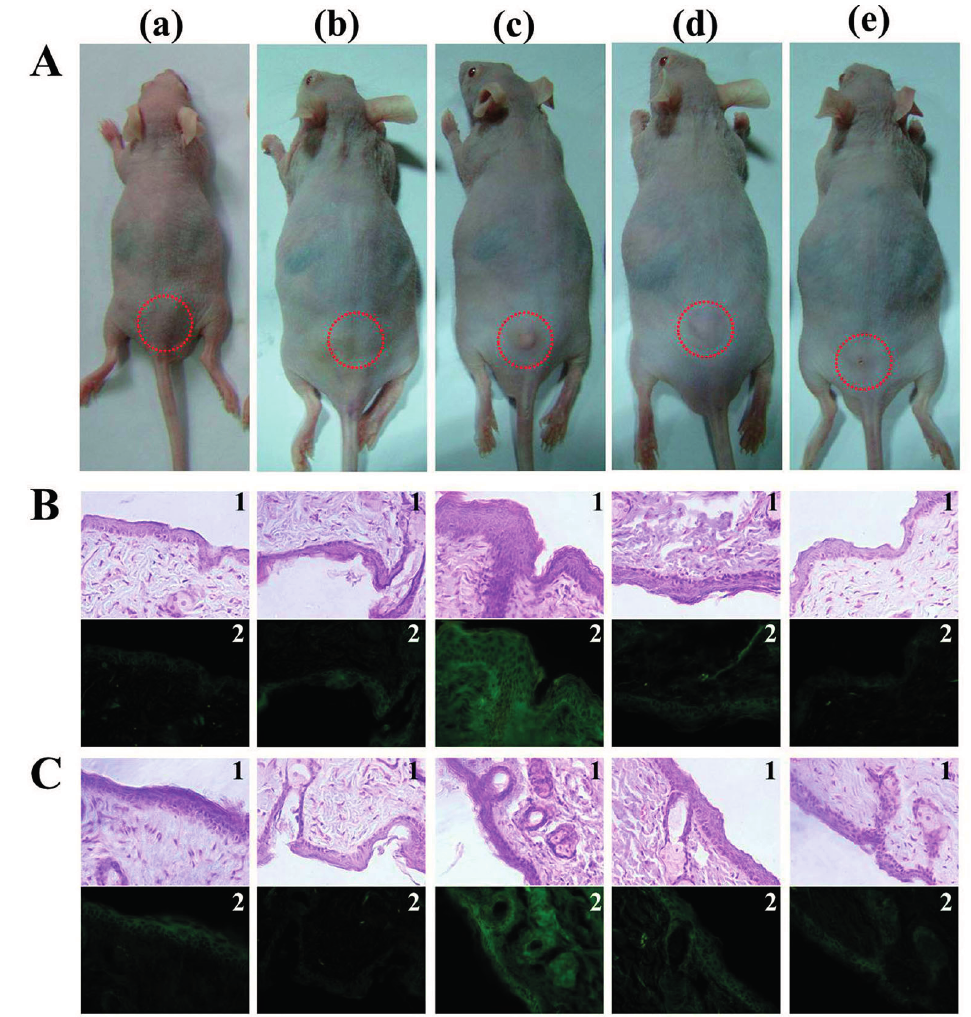
Figure 6. Topical application of beta-chitosan on the back skin of hairless mouse causes histological changes of dermatitis. S. aureus BMP-Sa003 (5 × 10 8 CFU/mL) was injected into back skin of hairless mouse, following injection of 0.5 or 1 mg/mL of β 10k chitosan. After immolation of mice ( A ) at 7 days, the tissues of dorsal skin was stained with hematoxylin and eosin staining (H & E) ( 1 ), and detected TNF- α ( B ) and IL-1 β ( C ) with FITC (Fluorecein isothiocyanate)-labeled ( 2 ) secondary antibody. The sectioned tissues were observed of magnification 40× under the inverted microscopy. ( a ) PBS (Phosphate-buffered saline); ( b ) 1 mg/mL of β 10k; ( c ) bacteria; ( d ) bacteria and 0.5 mg/mL of β 10k; ( e ) bacteria and 1 mg/mL of β